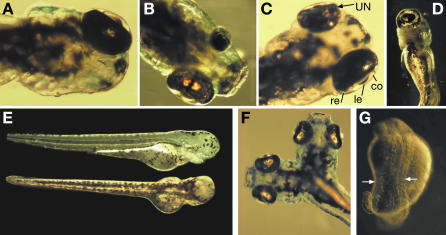
Eye Defects and Body-Axis Duplications Observed in AMN PopulationDorsal views shown are: (A) Unilateral anophthalmia; (B) Unilateral microphthalmia; and (C) Unilateral nanophthalmia (UN), illustrating retina (re), lens (le), cornea (co). (D) Ventral view of cyclopic embryo is shown. (E) Bilateral anophthalmia is shown (top, lateral view; bottom, dorsal view). (F) Anterior body-axis duplication (ABD), two complete heads formed; incomplete ABD were also observed (not shown). (G) Posterior body duplication (PBD), two notochords showing adjacent somite boundaries (arrows), culminating in two tails.